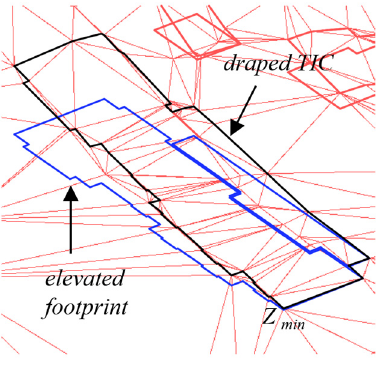
Figure 5. Building footprint and the